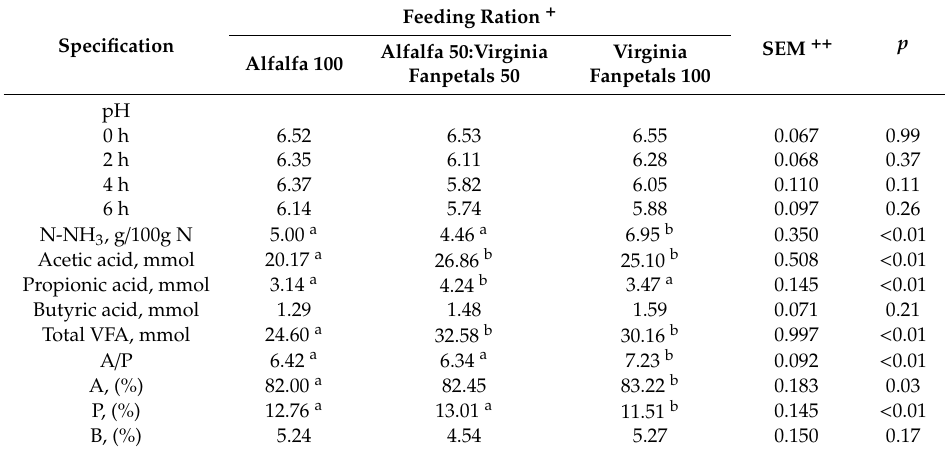
Table 4. Ruminal fermentation characteristics of lactating dairy cows fed di ff erent silage-diets.